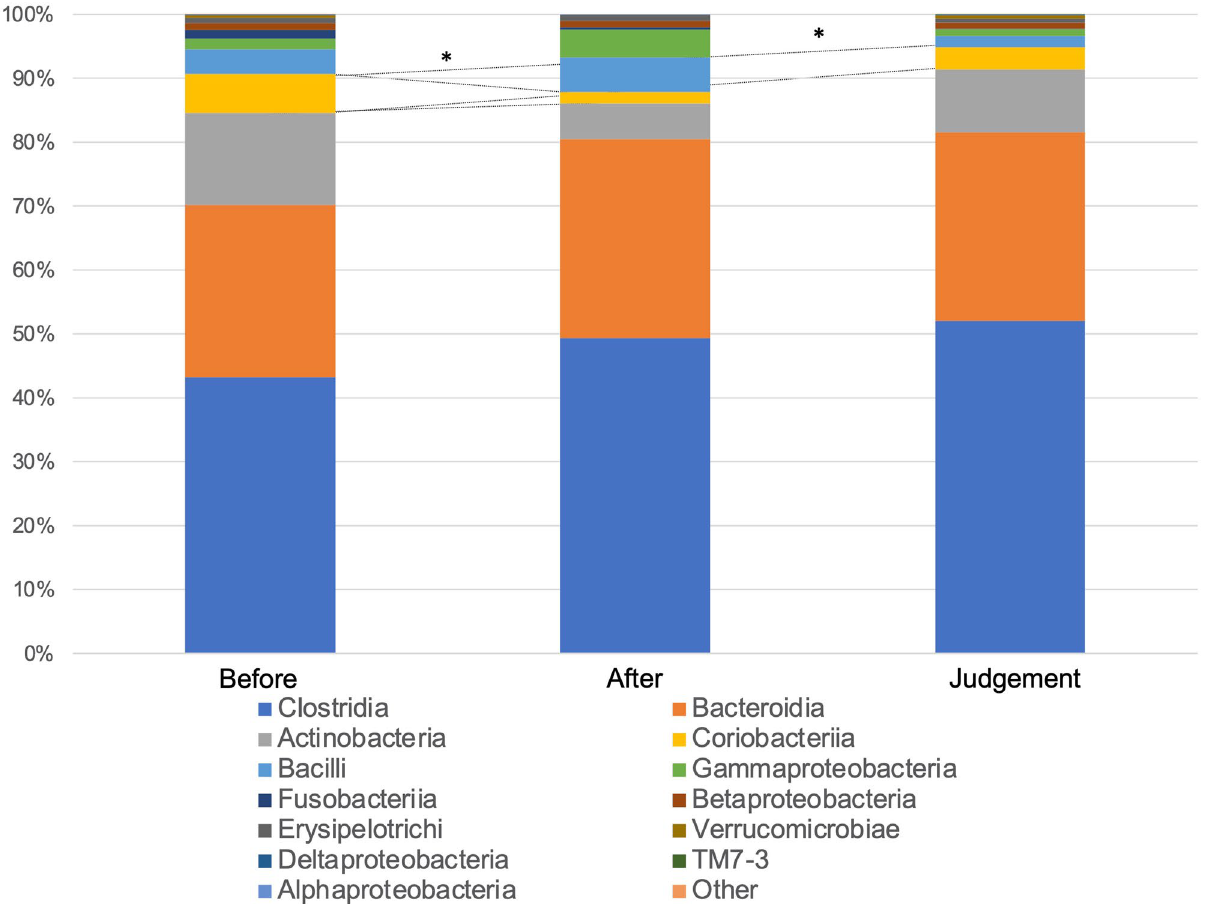
Figure 3. Relative abundance of the intestinal microbiota at the class level at the following three time points: before eradication therapy, after eradication therapy, and at the time of eradication therapy